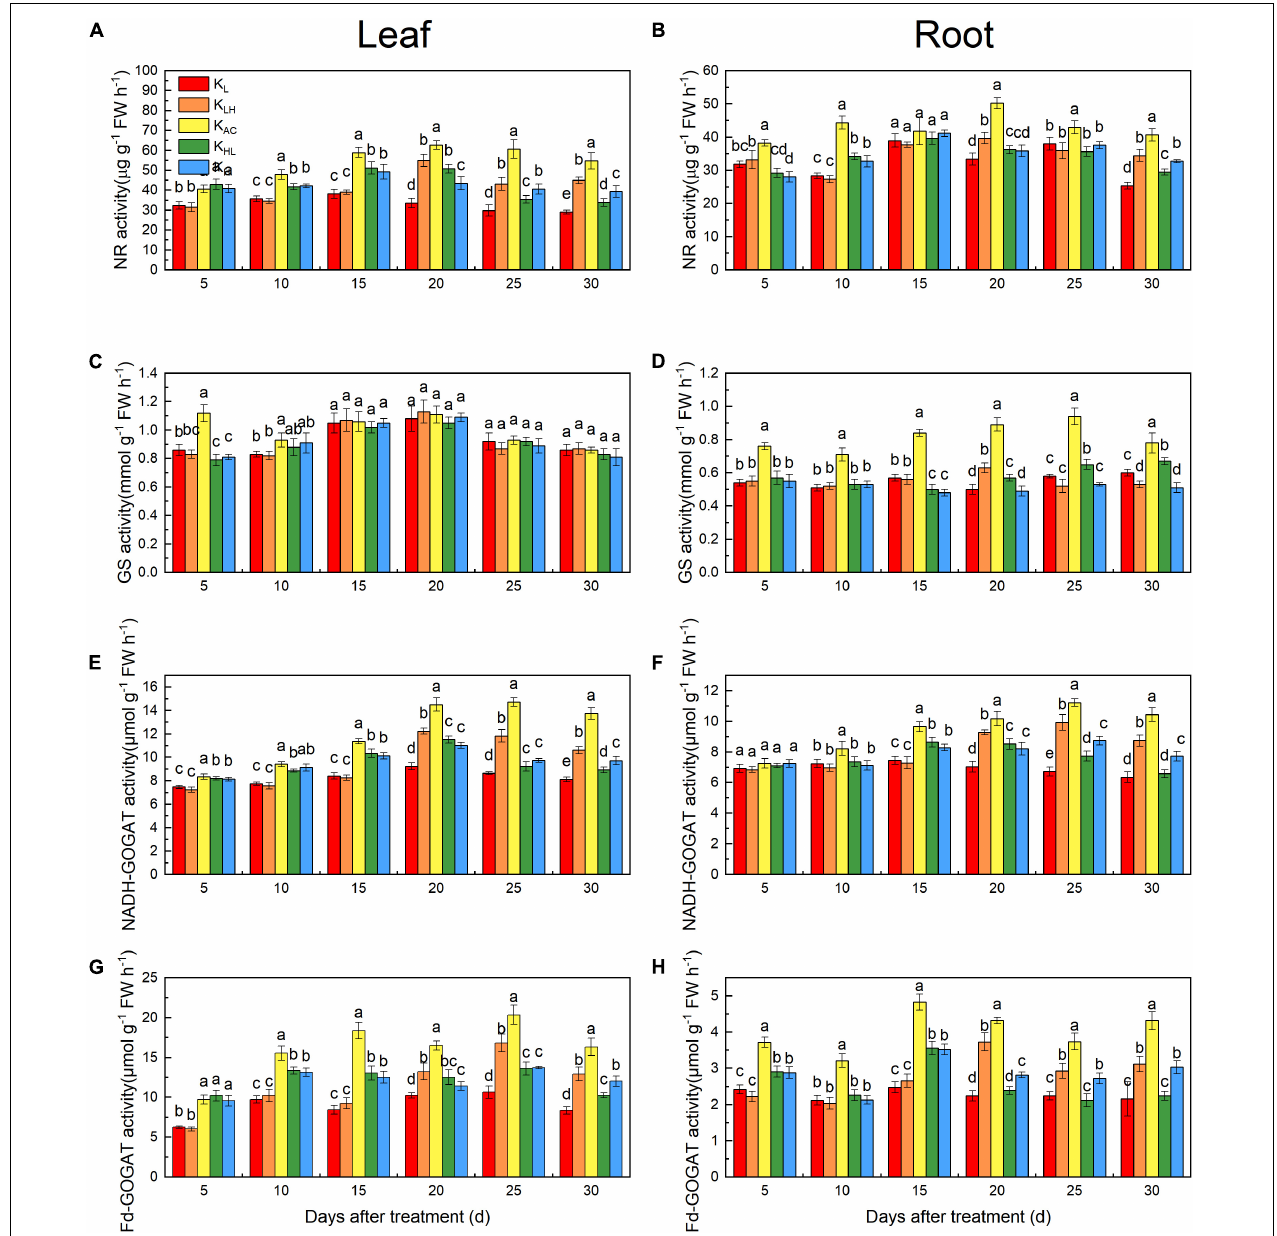
FIGURE 8 | Enzyme specific activities in leaves and roots: NR (A,B) , GS (C,D) , NADH-GOGAT (E,F) , Fd-GOGAT (G,H) of M9T337 rootstocks treated with different K treatments. Data show the means ± standard deviation of three independent samples. Different letters on vertical bars indicate significant differences ( P < 0.05).